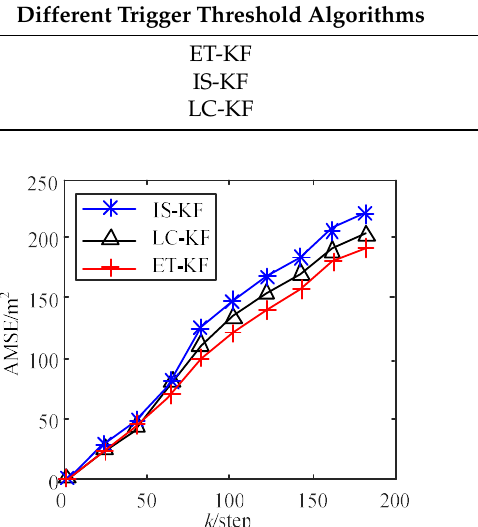
Different Trigger Threshold Algorithms